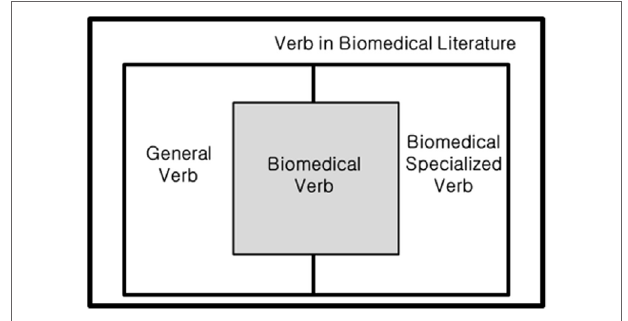
FigUre 2 | The definition of biomedical verbs.